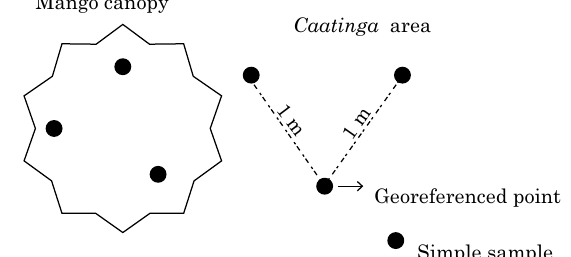
Figure 1. Sketch of collection of simple soil samples under the mango canopy and in the area of native caatinga